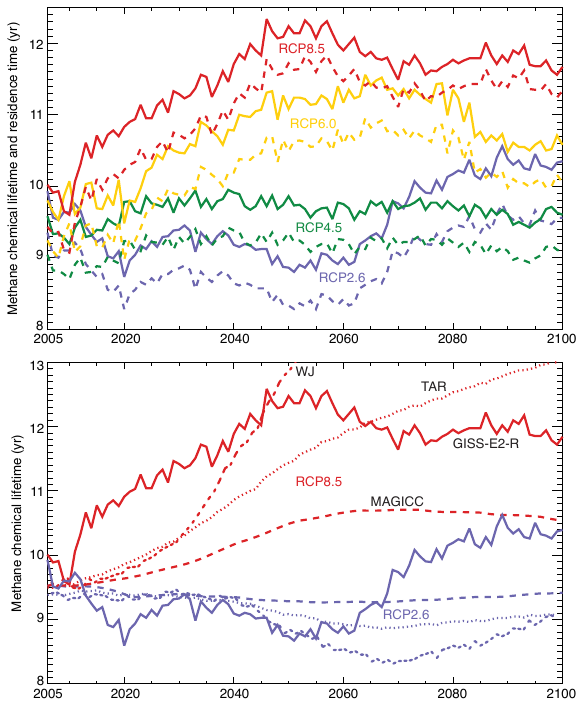
Fig. 22. Tropospheric methane chemical lifetimes (solid lines) and atmospheric residence times (dashed lines) in GISS simulations (upper panel), and tropospheric methane chemical lifetimes (thick solid lines) compared with lifetime estimates calculated using the IPCC TAR formulation (dotted lines), estimates from the MAGICC model used in creating the RCP methane concentrations (dashed lines) and estimates using the method of Wang and Jacob (WJ; long short dashes) (lower panel). Only two scenarios are shown in the lower panel for